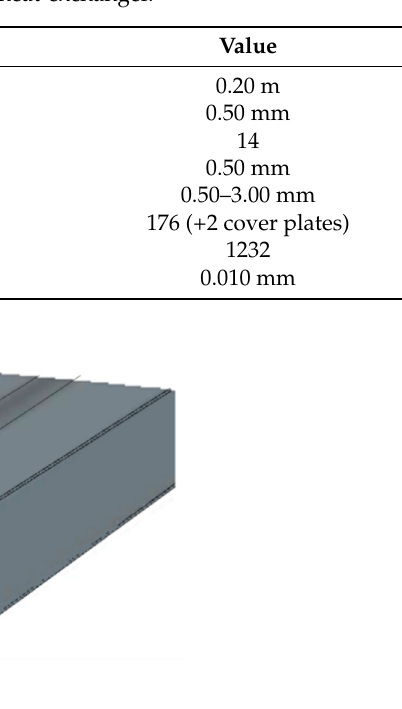
Table 1. Geometrical parameters of microreactor heat-exchanger.